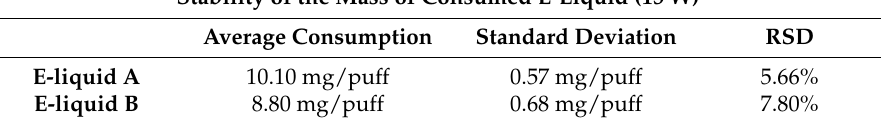
Table 1. Mass variation of aerosolized liquids A and B from 36 measurements per liquid (6 per Universal System for Analysis of Vaping (U-SAV) line) with the French association for standardization (AFNOR) standard protocol and a setting of 15 W in power mode, the standard deviation and the relative standard deviation (RSD).